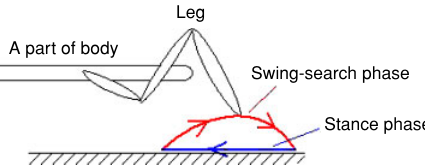
Figure 3 The two main phases in stick insect walking.